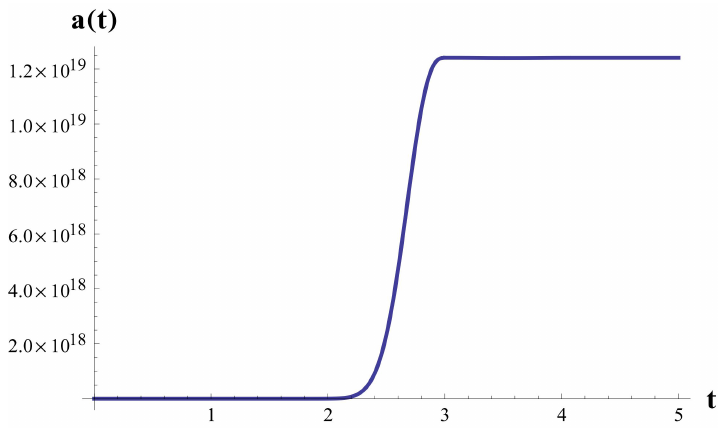
Figure 1. Numerical profile of a ( t ) with initial conditions a ( 0 ) = 10 − 20 , ˙ a ( 0 ) = 10 − 20 , ¨ a ( 0 ) = 10 − 17 , β = − 200 and k = 0.